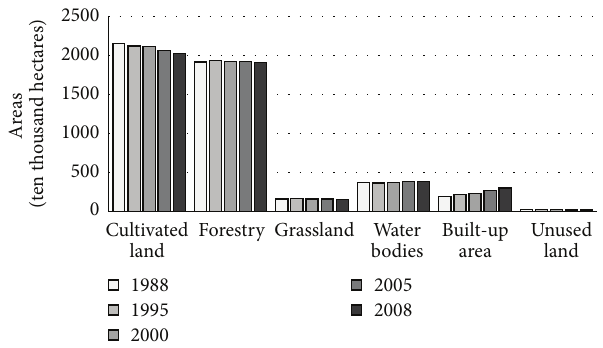
Figure 4: Structures of land-use in the middle and lower reaches of the Yangtze River, 1988–2008.